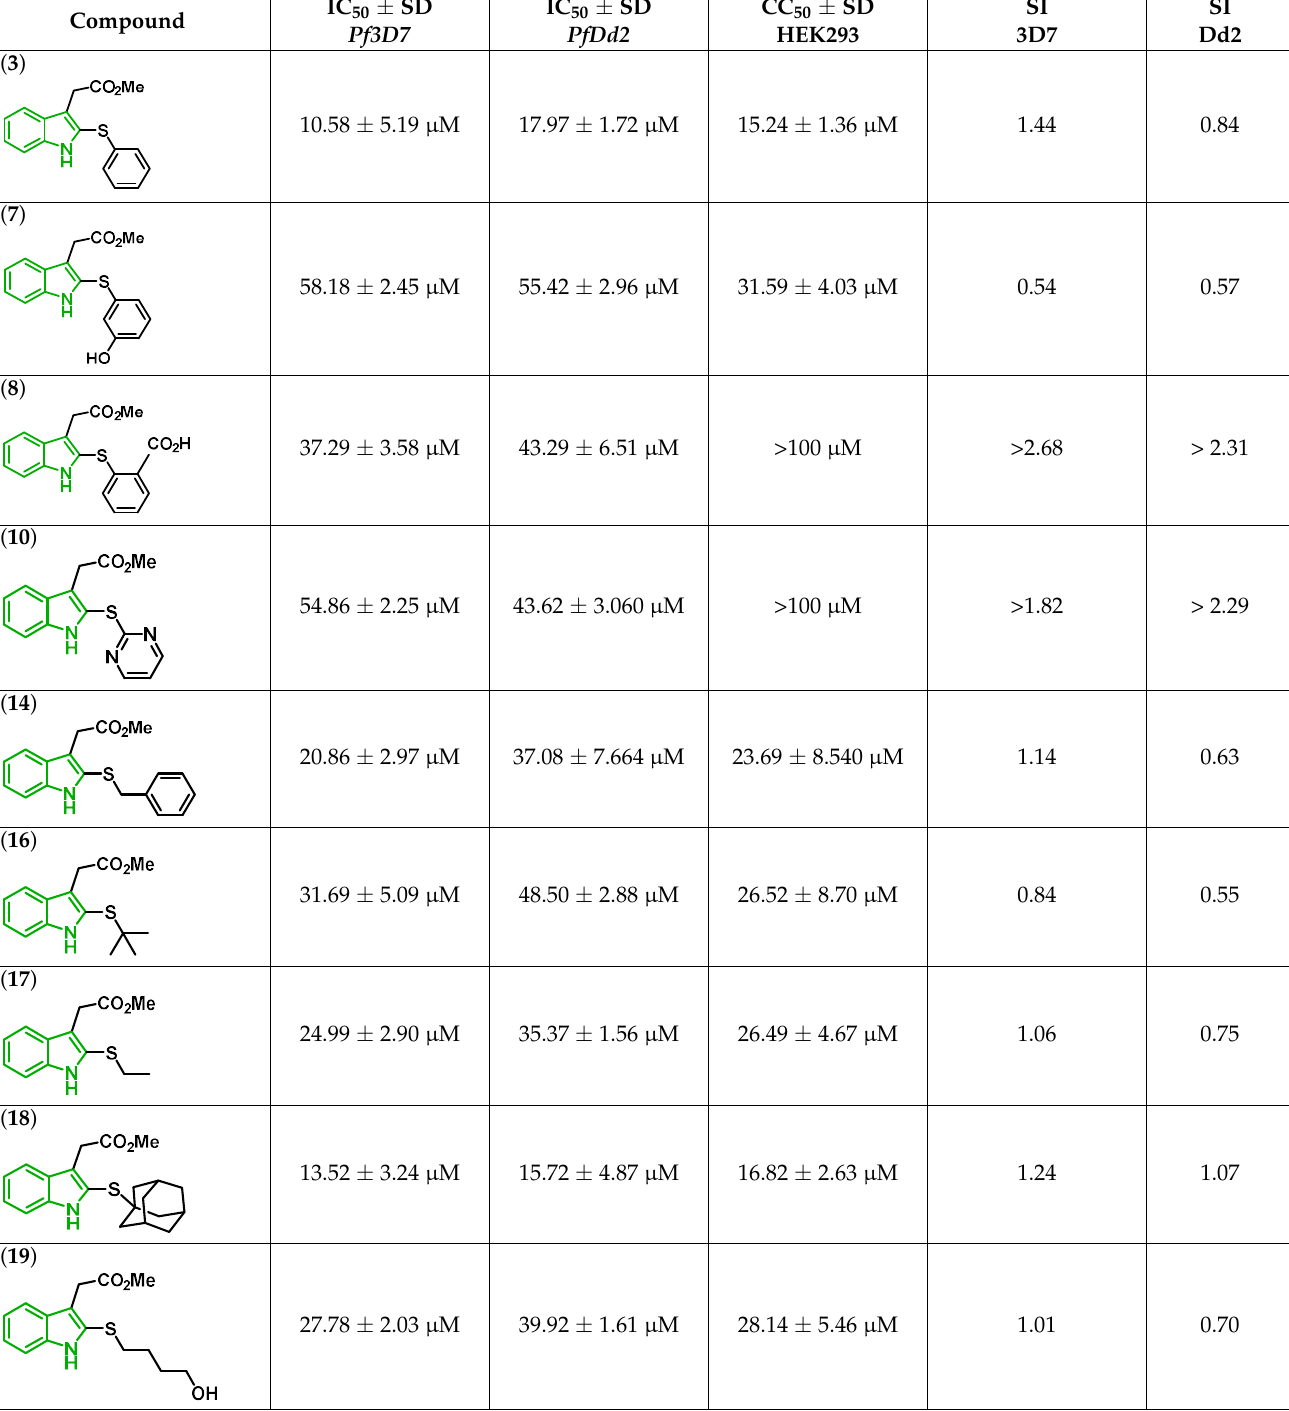
Table 1. In vitro activity of the compounds against asexual blood stages of Plasmodium falciparum and cytotoxicity in the HEK293 cell line.